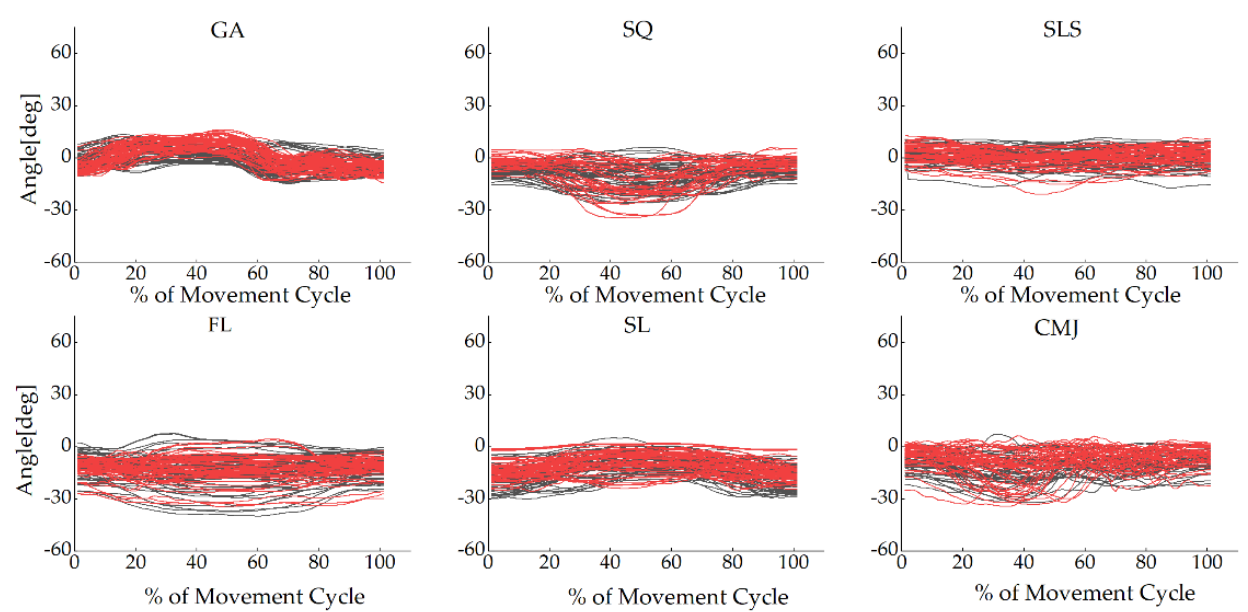
Figure A1. Hip joint angles in the frontal plane for each participant in all tasks during the movement cycle of the gait (GA), squat (SQ), single-leg squat (SLS), side lunge (SL), forward lunge (FL), and counter-movement jump (CMJ). The black lines represent the OptiTrack system, while the red lines represent the Perception Neuron ® system. The Y -axis depicts joint angles in degrees, while the X -axis depicts the movement cycle in %.